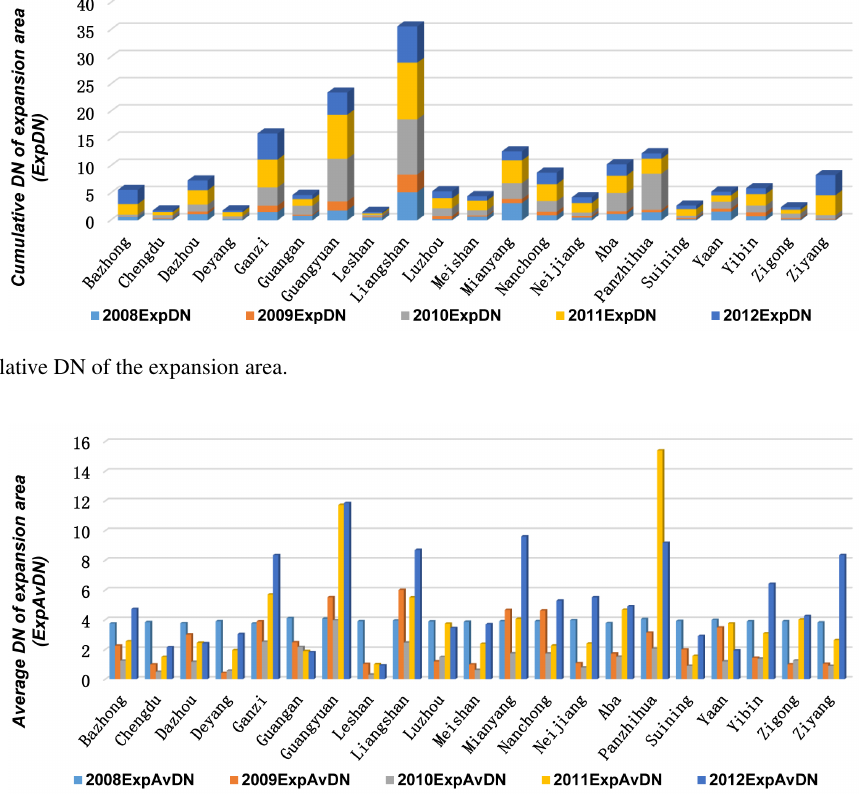
Figure 12. The average DN in the expansion area.